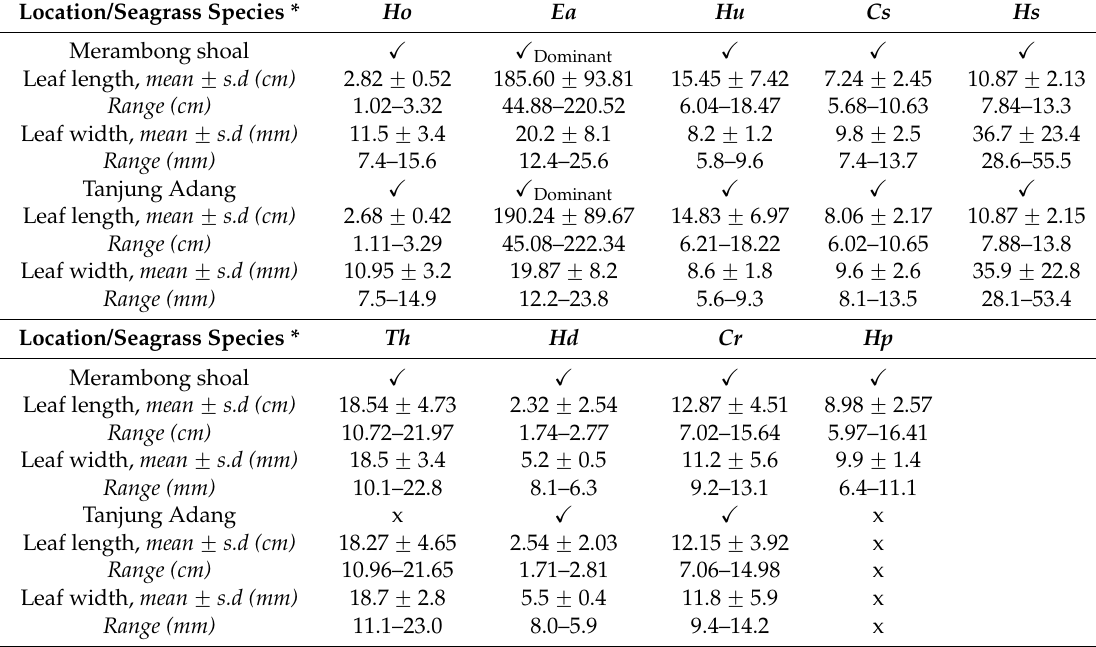
Table 1. Summary of characteristics of seagrass species at study area based on observations in February 2009 and June 2013. Standard deviation is